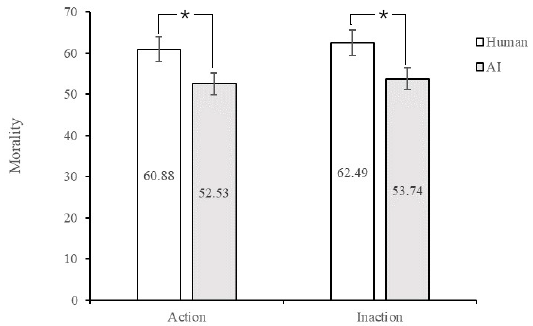
Figure 1. Rates of morality on human and AI agents. Note. * p < 0.05.